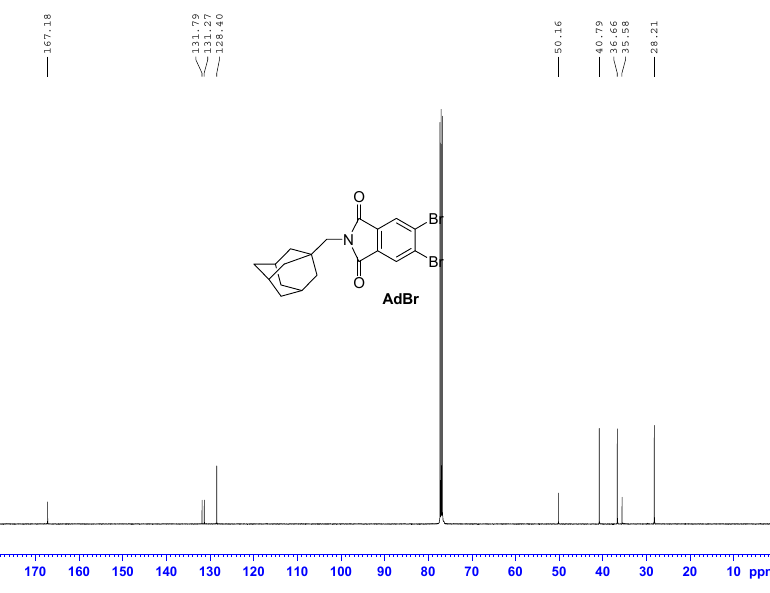
Figure 2. 13 C-NMR (CDCl 3 ) spectrum of AdBr.